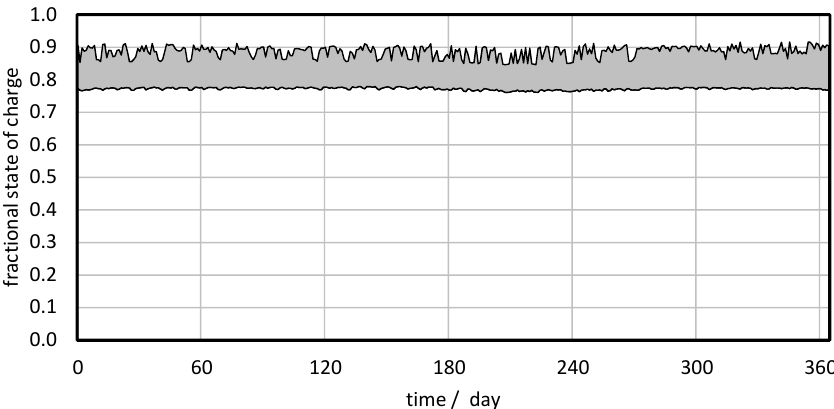
Figure 14. Daily low and high limits of the fractional state of charge of the batteries in the SOPE.